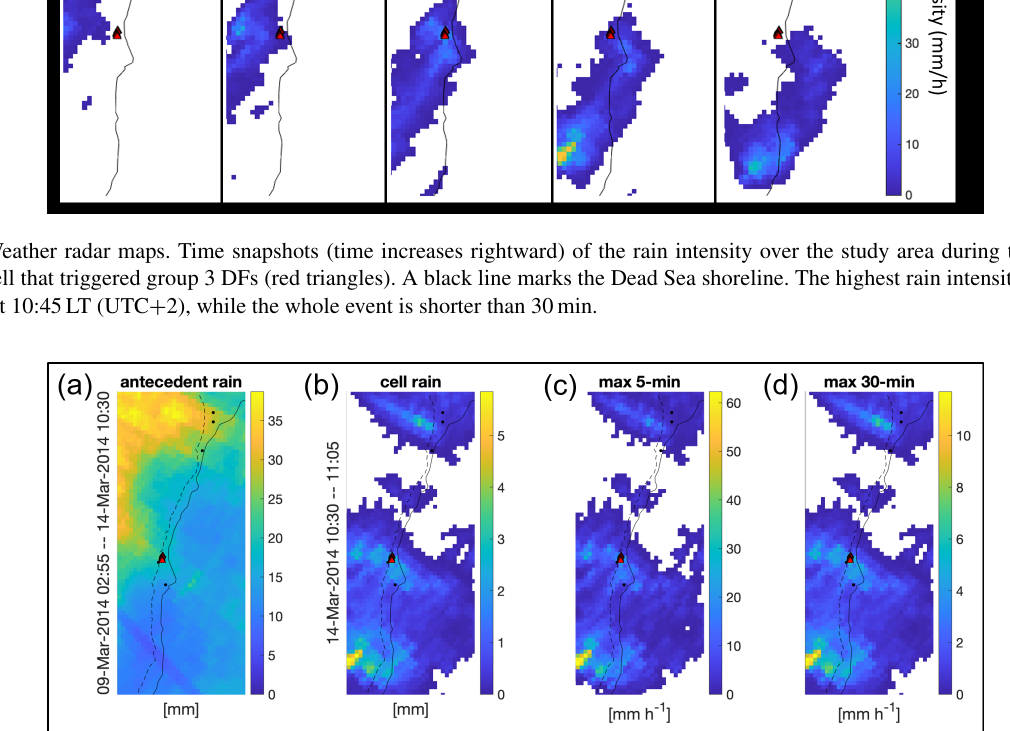
Figure 9. Rainfall leading to DFs for the event shown in Fig. 8. The clifftop (dashed line), together with the Dead Sea shoreline (solid line), marks the narrow band of steep escarpment where debris flows may potentially be triggered. Black dots show the location of the rain gauges. (a) Antecedent rainfall – map of the total rainfall during the March 2014 event until the onset of the trigging cell. (b) The total rainfall observed during the triggering cell (10:30–11:05LT). (c) Peak intensity of the triggering cell (5min time interval). (d) Peak intensity of the triggering cell (30min time